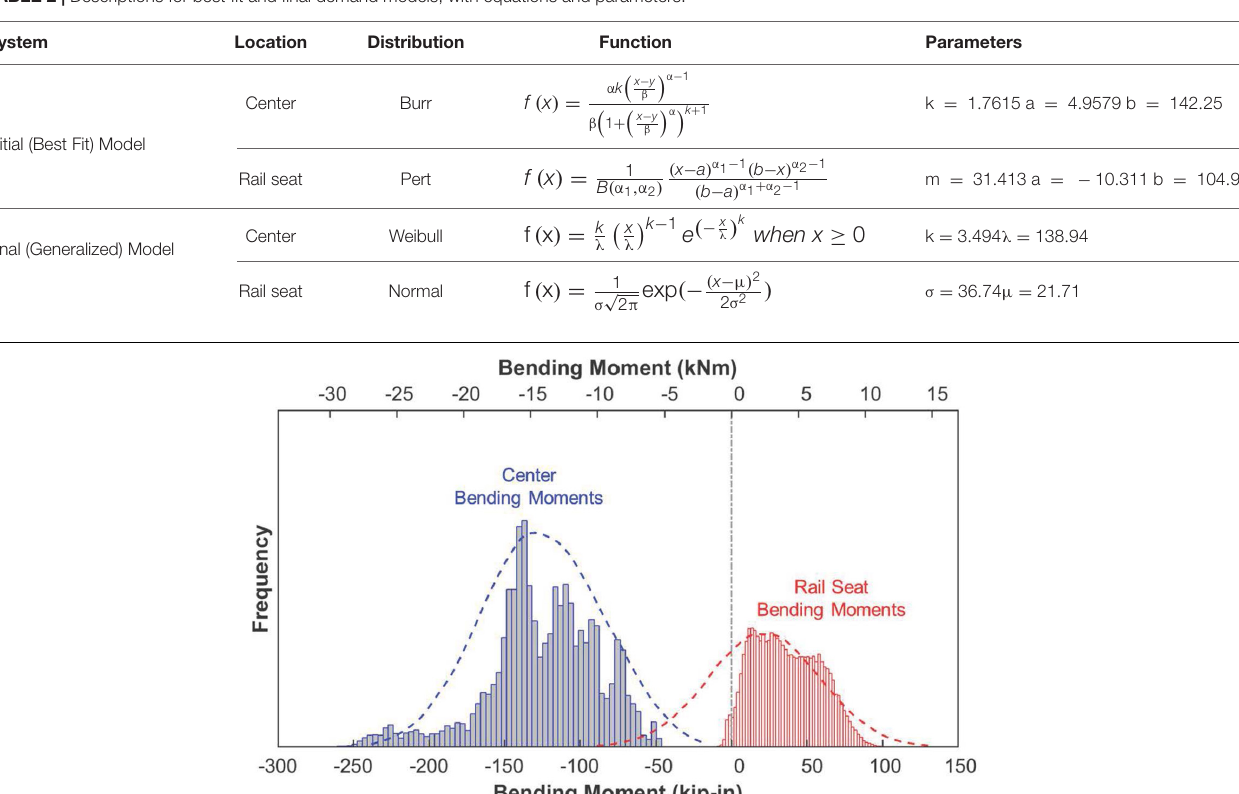
FIGURE 4 | Histogram of raw data of sleeper rail seat and center bending moments used to generate demand models for HAL freight. TABLE 2 | Descriptions for best fit and final demand models, with equations and parameters.